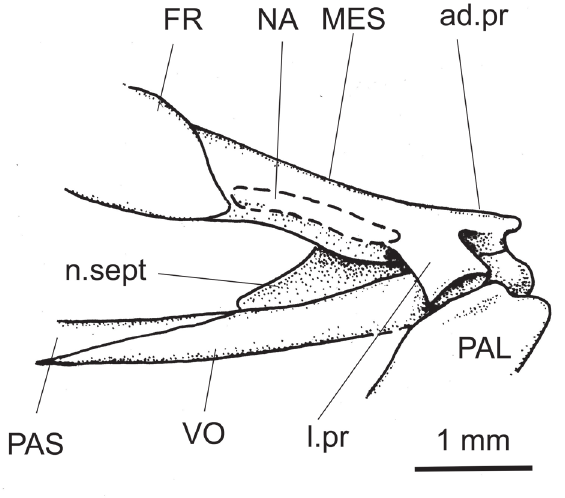
Figure 3. † Scutatuspinosus itapagipensis Santos and Corrêa 1985: restoration of ethmoidal region based on DGM